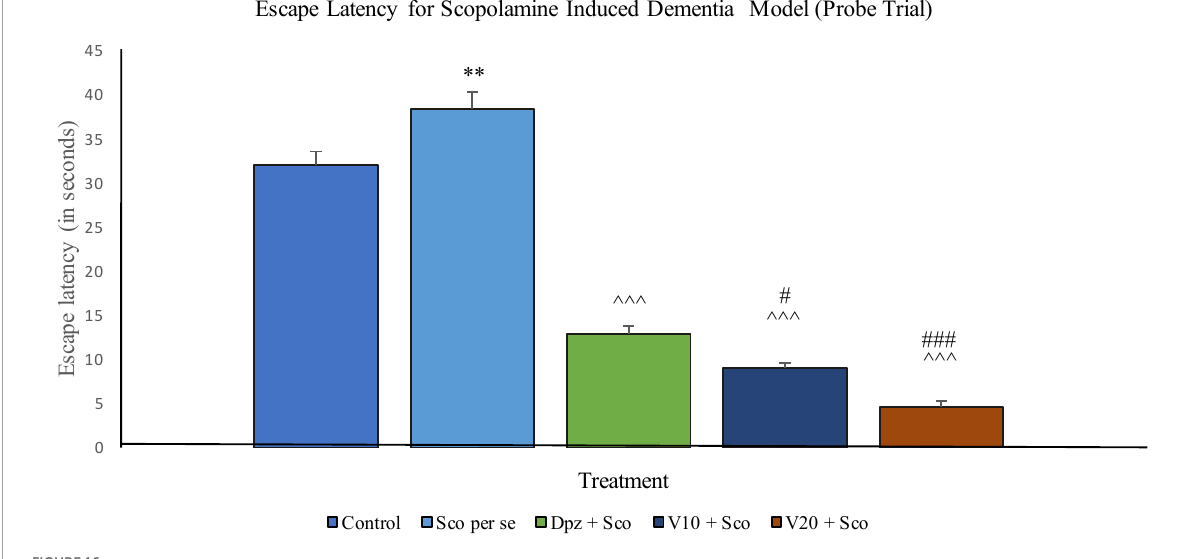
FIGURE16 Effect of vanillin and other treatments on escape latency (probe trial). Data are expressed as mean ± SEM. “**” denotes P < 0.01 with respect to the control group within the probe trial. “###” denotes P < 0.001 with respect to the standard treatment group within the probe trial, “#” denotes P < 0.05 with respect to the standard treatment group within the probe trial. “ ∧∧∧ ” denotes P < 0.001 with respect to the negative control (Sco per se ) group within the probe